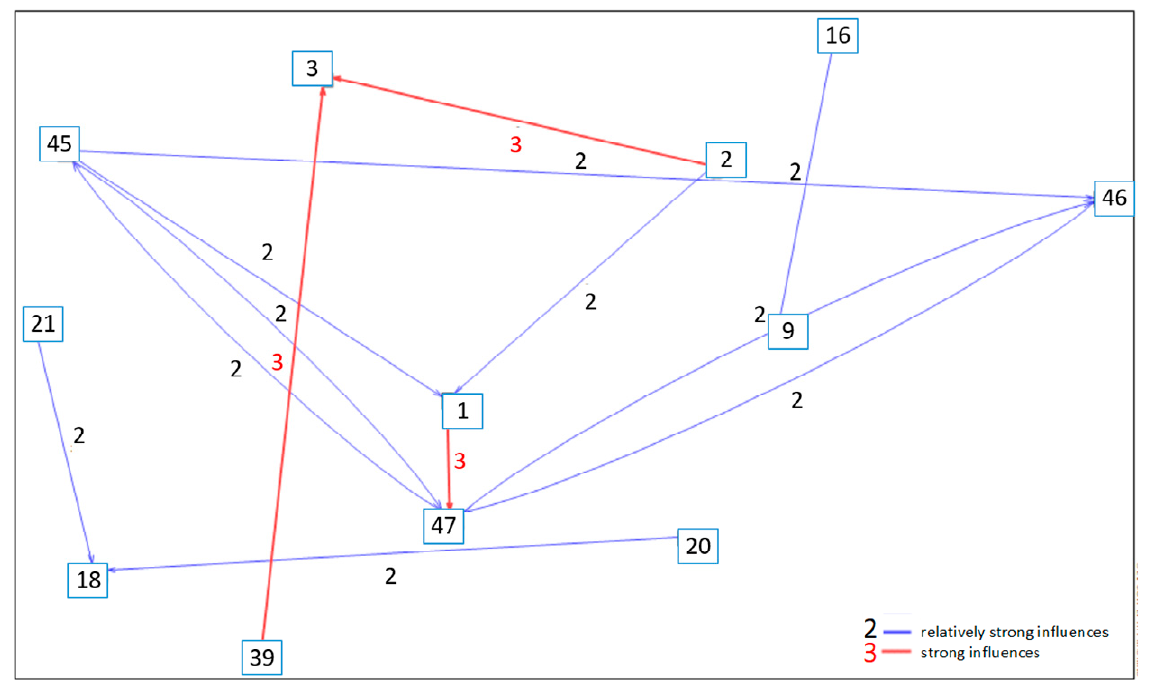
Figure 6. Direct influences graph, the numbers in the graph correspond to the number of the variables in Table 1, the result of data processing by the MICMAC software.